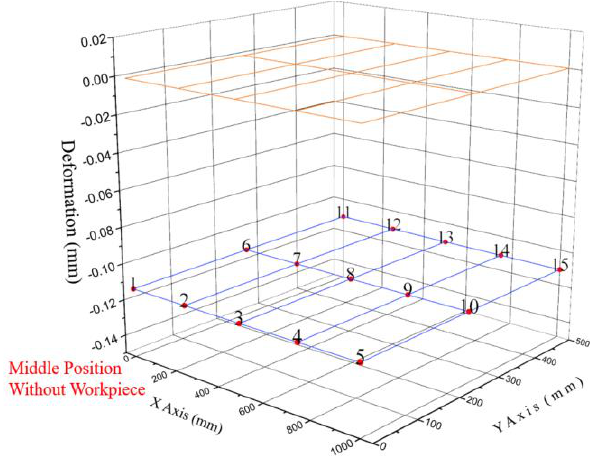
Figure 10. Schematic diagram of no load at the midpoint of the spindle.